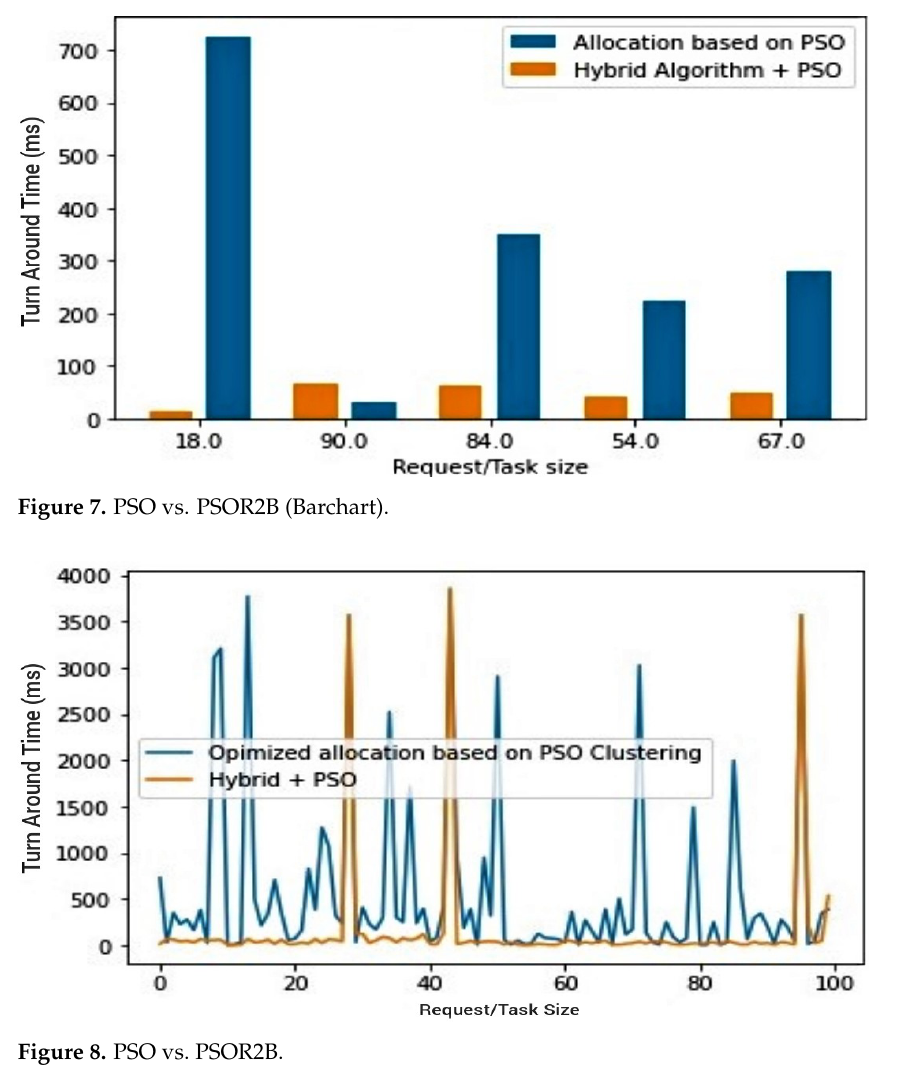
Figure 8. PSO vs. PSOR2B.